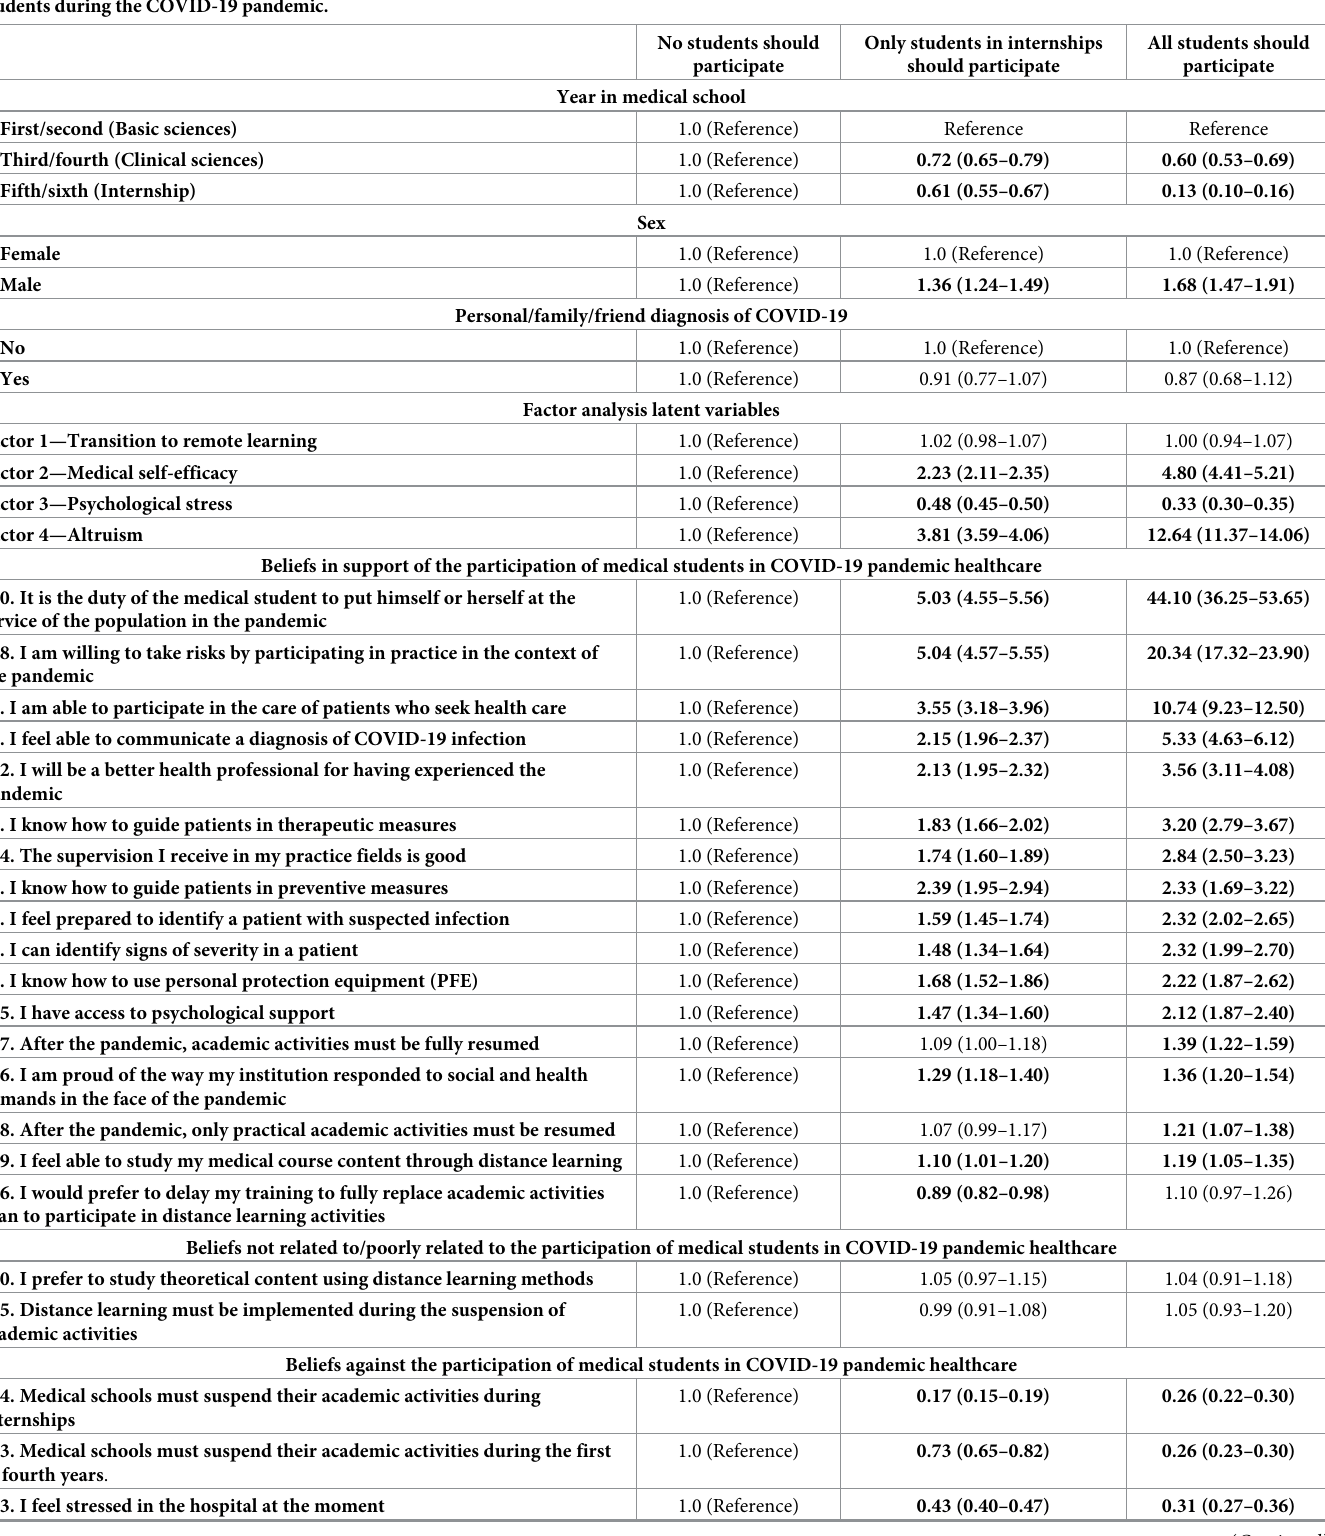
Table 3. Adjusted odds ratios (95% confidence intervals) for the association between students’ characteristics and perceptions and their views on the role of medical students during the COVID-19